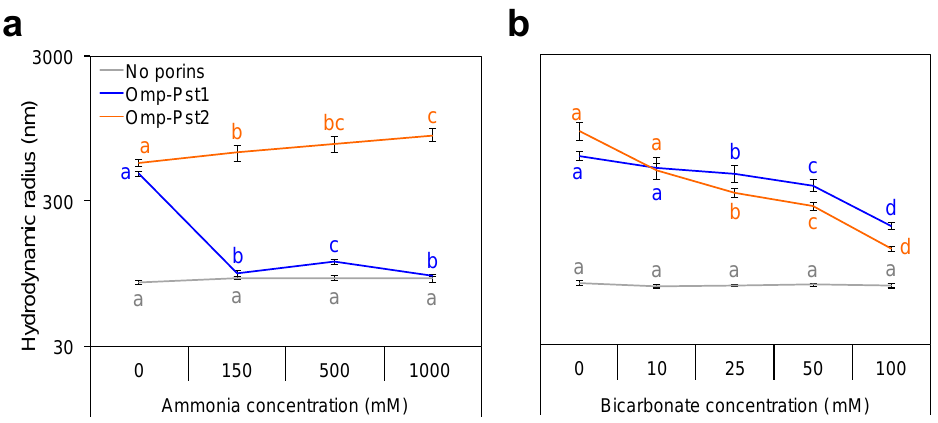
Figure 4. Ammonium and bicarbonate both inhibit self-association of Omp-Pst1, but that of Omp-Pst2 is only challenged by bicarbonate. LDAO-solubilized Omp-Pst1 (blue) and Omp-Pst2 (orange) were reconstituted in ~50-nm radius LUV, in presence of increasing concentrations of ammonia ( a ) or bicarbonate ( b ), and after 24 h incubation with biobeads, the hydrodynamic radius of proteoliposomes was measured by DLS. The hydrodynamic radii of LUVs incubated at with the cues but without porin were also measured (grey). Different letters above the bars indicate significant differences ( p < 0.05; ANOVA followed by post-hoc Tukey HSD test; see statistical indicators in Supplementary Table S3).